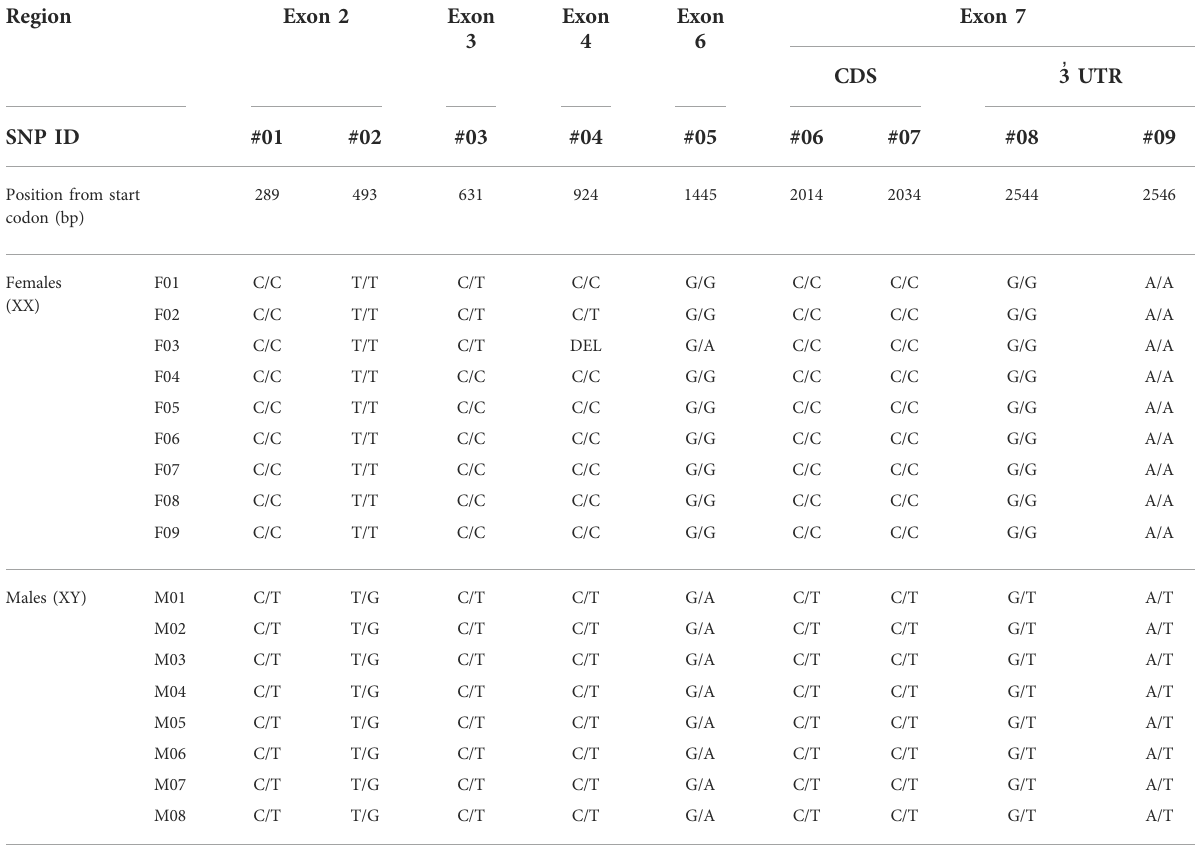
TABLE 4 Detailed characterization of SNPs detected in the coding regions of amh gene in XX and XY genotypes.